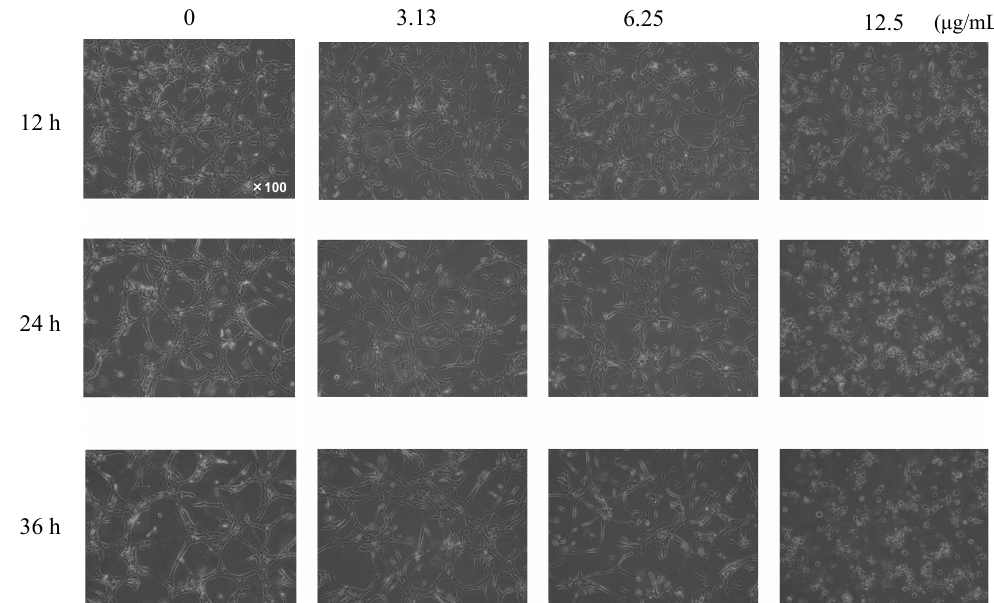
Figure 5. Inhibitory effects of ferulenol ( 2 ) on the tube formation of HUVECs. The compound showed a very strong antiangiogenic activity, inhibiting the formation of capillary networks and inducing cell fragmentation dose-dependently even at lower concentrations.